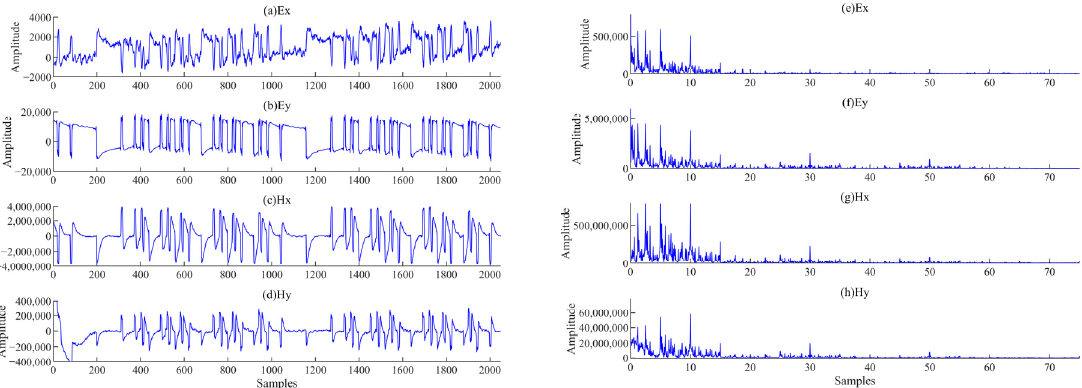
Figure 15. The noise isolated by DRSN. Time domain waveform of ( a ) Ex component; ( b ) Ey com- ponent; ( c ) Hx component; ( d ) Hy component. Spectrum of ( e ) Ex component; ( f ) Ey component; ( g ) Hx component; ( h ) Hy component.